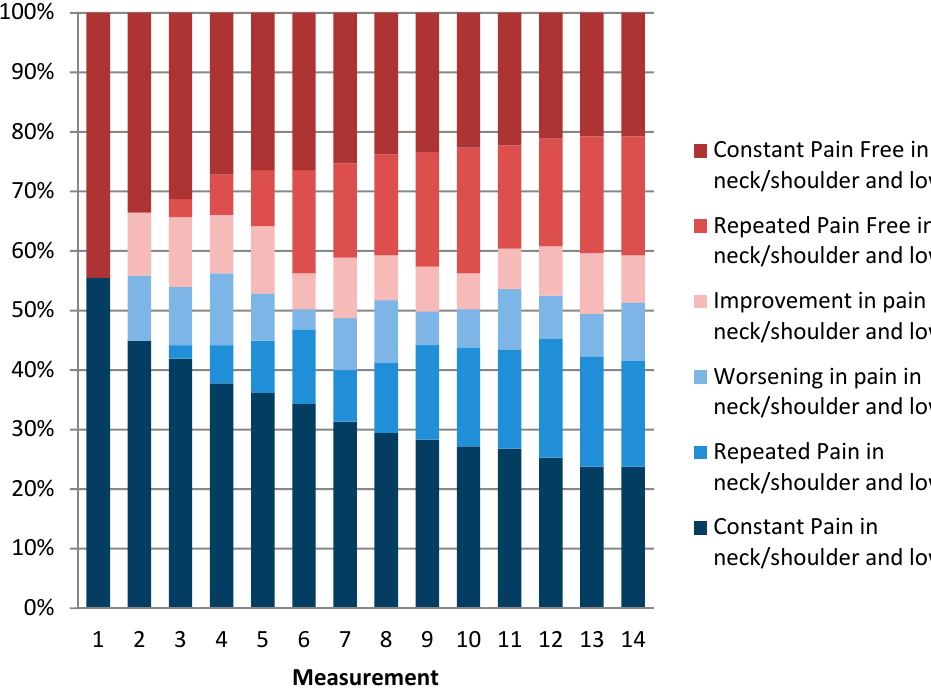
Figure 4. Patterns of combined low back pain and neck/shoulder pain episodes over one year.